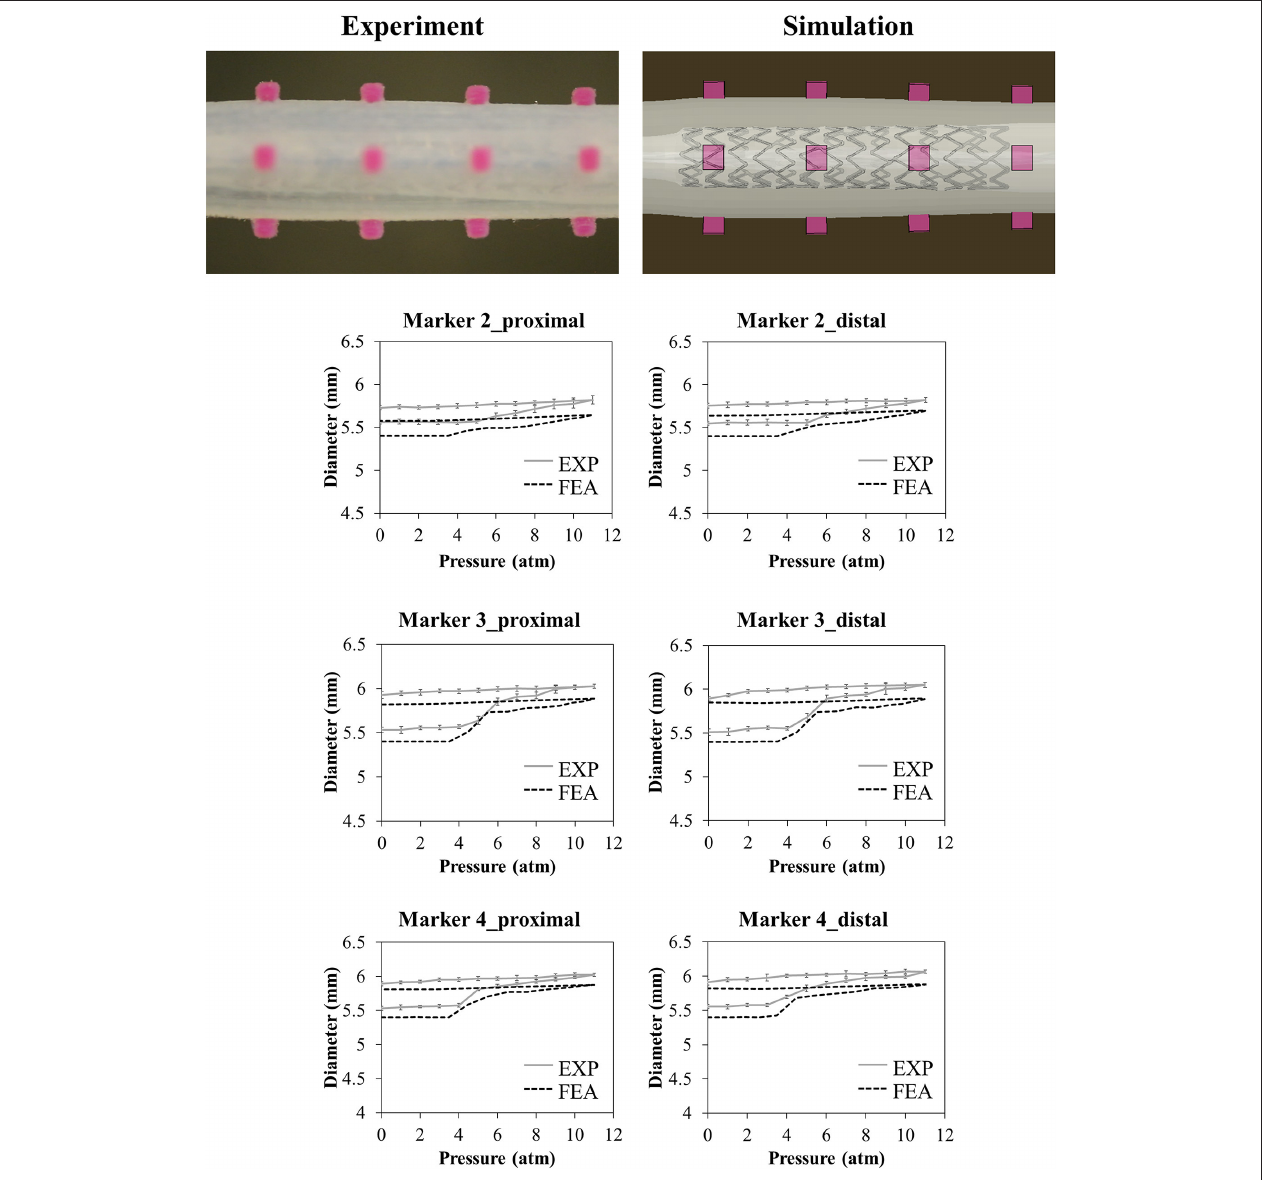
FIGURE 5 | Comparison between experimental (mean values and relative experimental variability) and numerical results of the deployment of SYNERGY TM in an idealized vessel, taken at Marker 2, 3, 4 (from proximal to distal, Marker 1 remained unaffected by the procedure due to its lateral position). A qualitative comparison between experimental and numerical configuration is reported considering the final instant of the balloon deflation